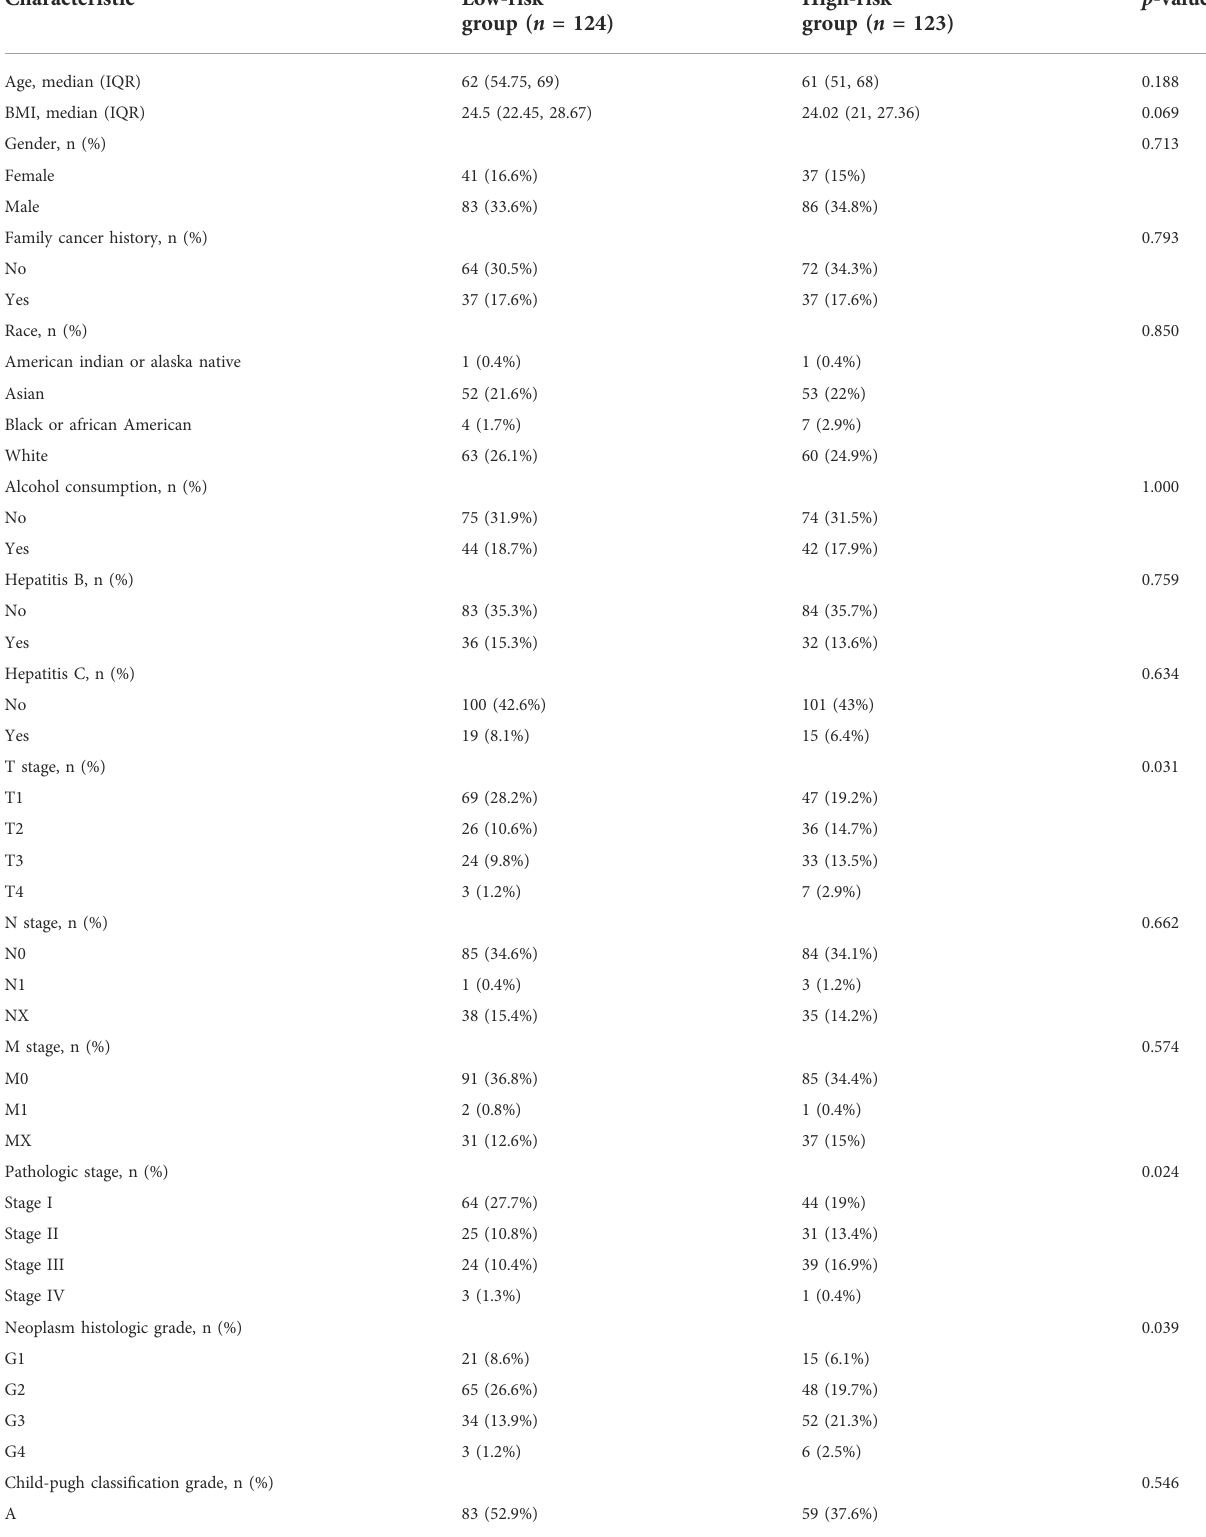
TABLE 2 Associations between the signature and patients ’ characteristics in the training